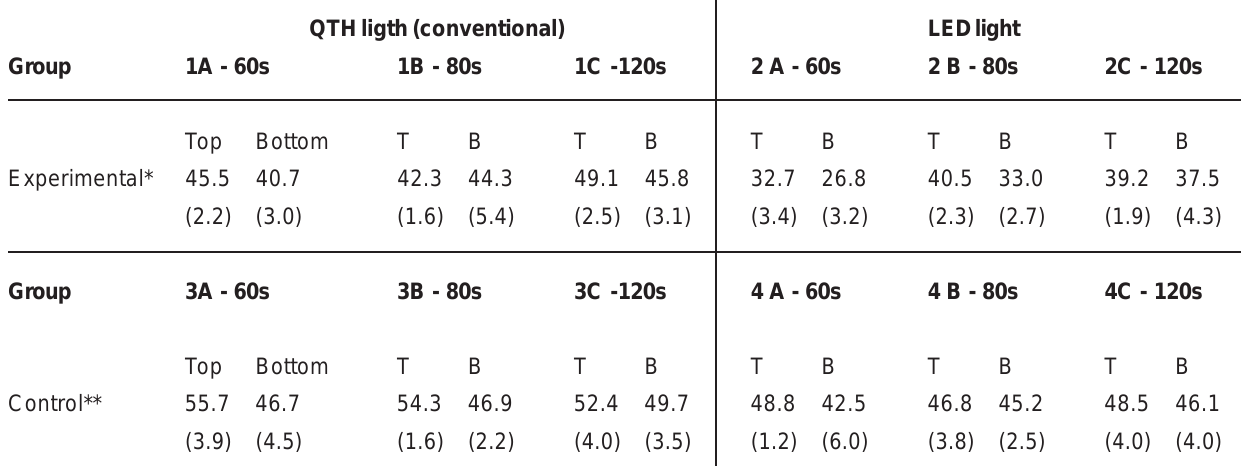
*Experimental: light-curing with ceramic interposition **Control: light-curing with no ceramic interposition